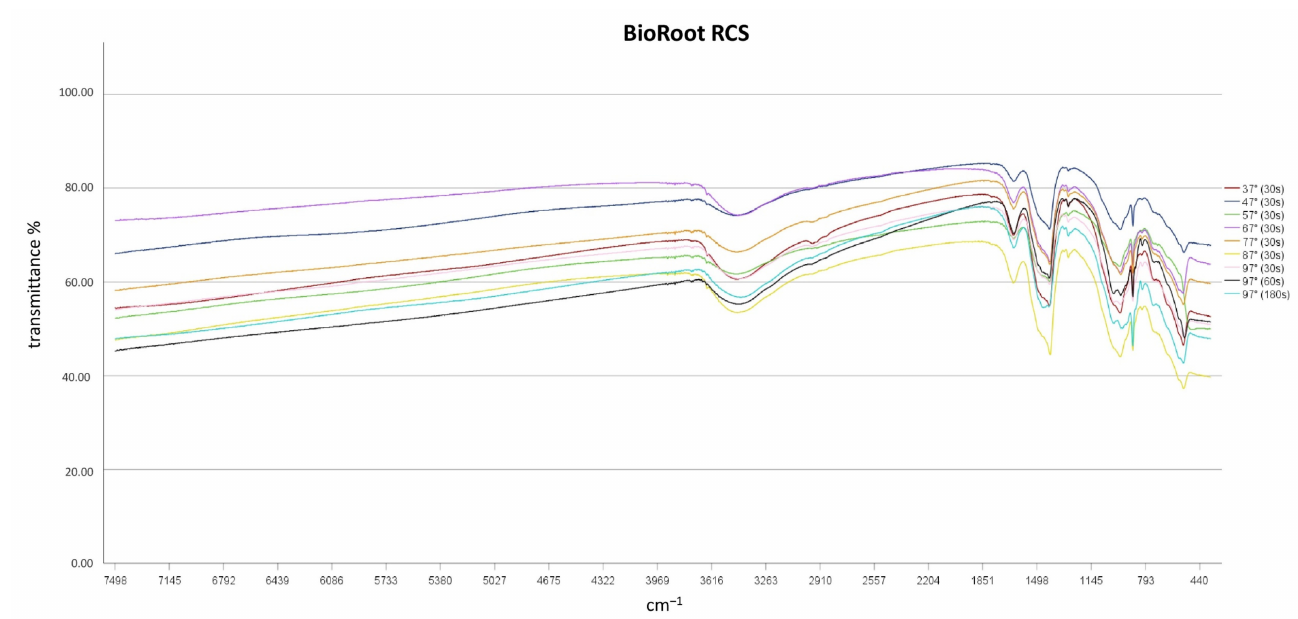
Figure 4. FT-IR spectroscopic plots of BioRoot